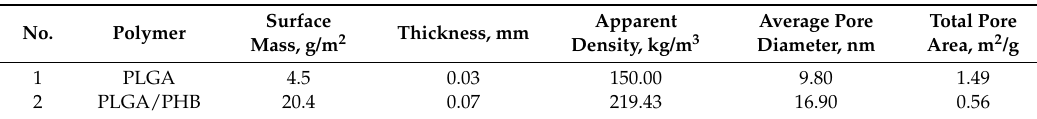
Table 3. Characteristic of the nanoporous layer constituting the